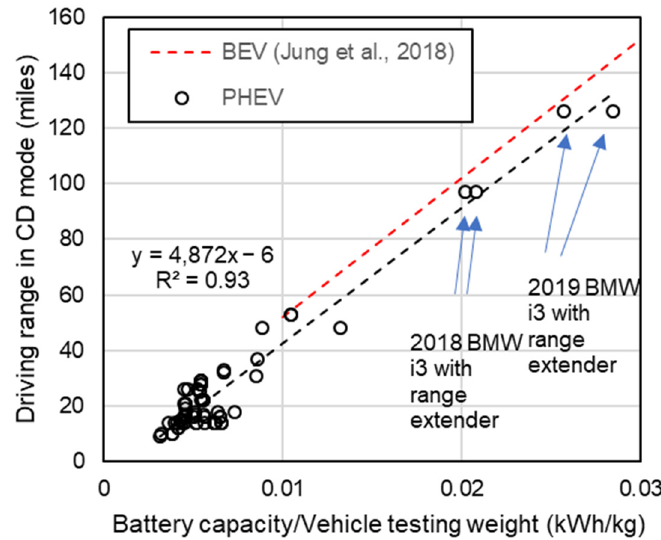
Figure 1. Trend of US Environmental Protection Agency (EPA) driving range (miles) per charge vs battery capacity/vehicle testing weight (kWh/kg) in charge-depleting (CD) mode.